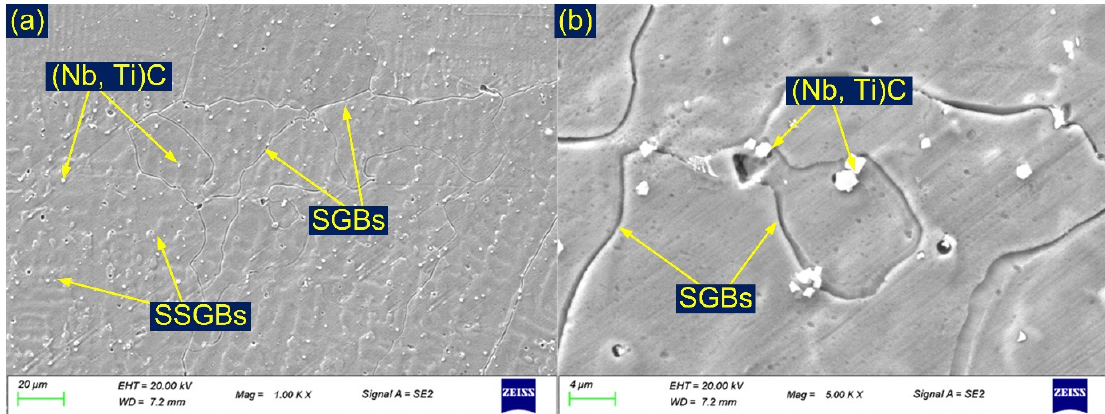
Figure 9. ( a,b ) ENiCrFe-3 filler weld metal.